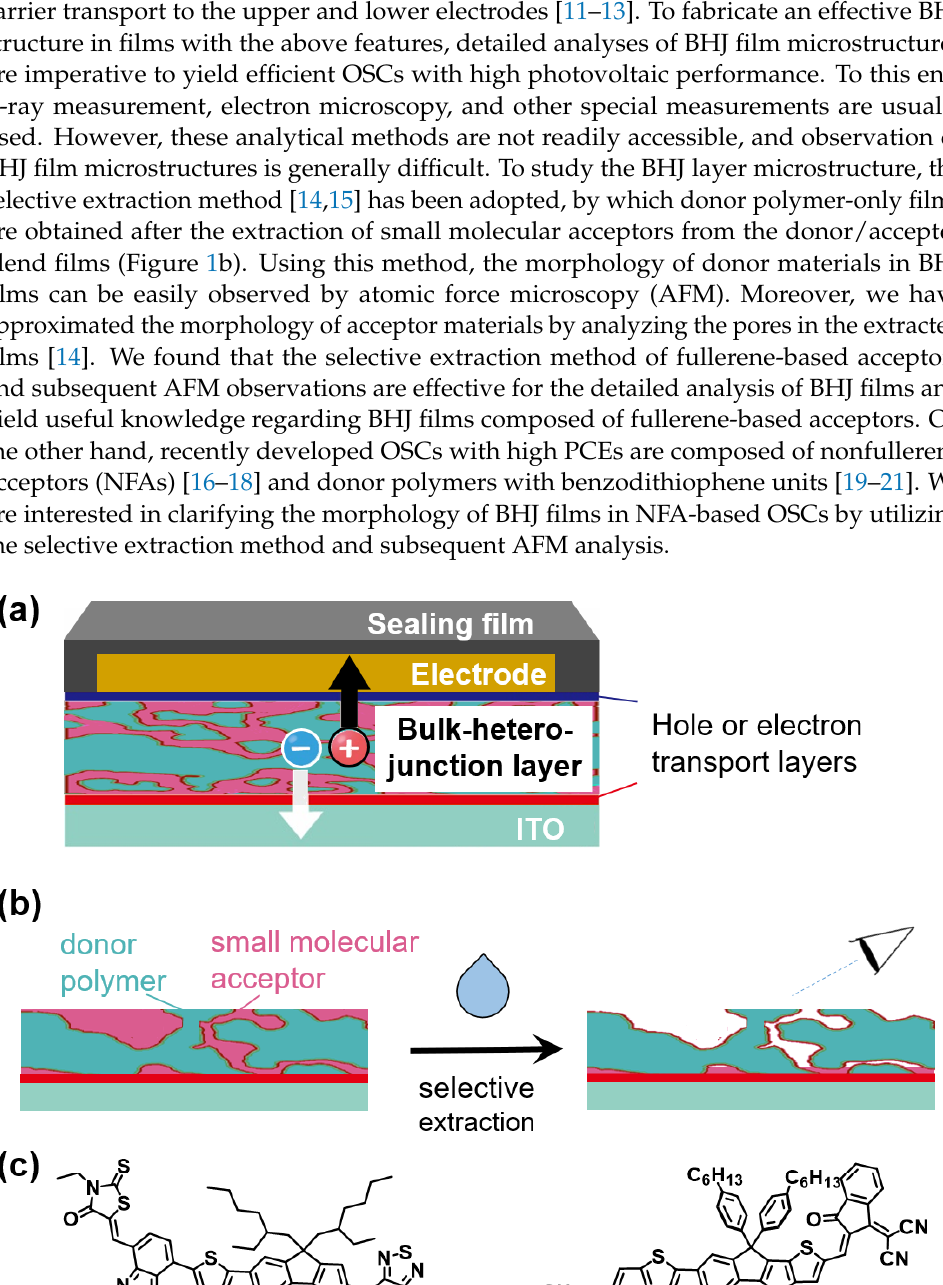
Figure 1. Typical structure of OPV device with BHJ layer ( a ), illustration of selective extraction method and subsequent analysis of donor/acceptor blend films ( b ), and chemical structures of NFAs ( c ) and donor polymers ( d ). 2. Materials and Methods 2.1. Materials We used [(5 Z ,5′ Z )-5,5′-{[(4,4,9,9-tetra(2-ethylhexyl)-4,9-dihydro-s-indaceno[1,2- b :5,6- b ’]dithiophene-2,7-diyl)bis(benzo[ c ][1,2,5]thiadiazole-7,4-diyl)]bis(methanylyli- dene)}bis(3-ethyl-2-thioxothiazolidin-4-one)] (EH-IDTBR) and 3,9-bis[2-methylene-{3- (1,1-dicyanomethylene)-indanone}]-5,5,11,11-tetrakis(4-hexylphenyl)-dithieno[2,3- d :2′,3′- d ’]- s -indaceno[1,2- b :5,6- b ’]dithiophene (ITIC), representative nonfullerene acceptors with good solubility, and poly[4,8-bis((2-ethylhexyl)oxy)benzo[1,2- b :4,5- b ’]dithiophene-2,6- diyl- alt -2-((2-ethylhexyl)oxycarbonyl)-3-fluorothieno[3,4- b ]thiophene-4,6-diyl (PTB7) and poly[(2,6-{4,8-bis[5-(2-ethylhexyl)thiophen-2-yl]benzo[1,2- b :4,5- b ’]dithiophene})- alt -{5,5- [1´,3´-di(thiophen-2-yl)-5´,7´-bis(2-ethylhexyl)benzo[1´,2´- c :4´,5´- c ´]dithiophene-4´,8´-di- one]}] (PBDB-T), donor materials which are widely used for OSC devices, zinc acety- lacetonate hydrate (99.995%, trace metals basis) as a precursor for the electron transport- ing layer film, and poly(3,4-ethylenedioxythiophene):poly(4-styrene sulfonate) (PE- DOT:PSS) (Clevios P) as a material for hole transporting layer. These materials were pur- chased from 1-Material Inc. (Dorval, QC, Canada) and Sigma-Aldrich (St. Louis, MO, USA). The indium tin oxide (ITO) substrates (sheet resistance = 10 Ω sq) and Au (99.99%) were purchased from the Furuuchi Chemical Corporation (Tokyo, Japan).